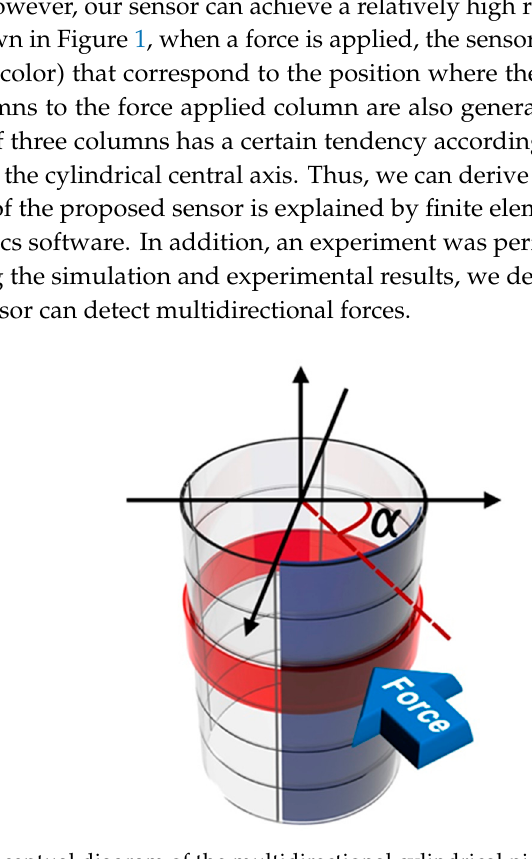
Figure 1. Conceptual diagram of the multidirectional cylindrical piezoelectric force sensor.